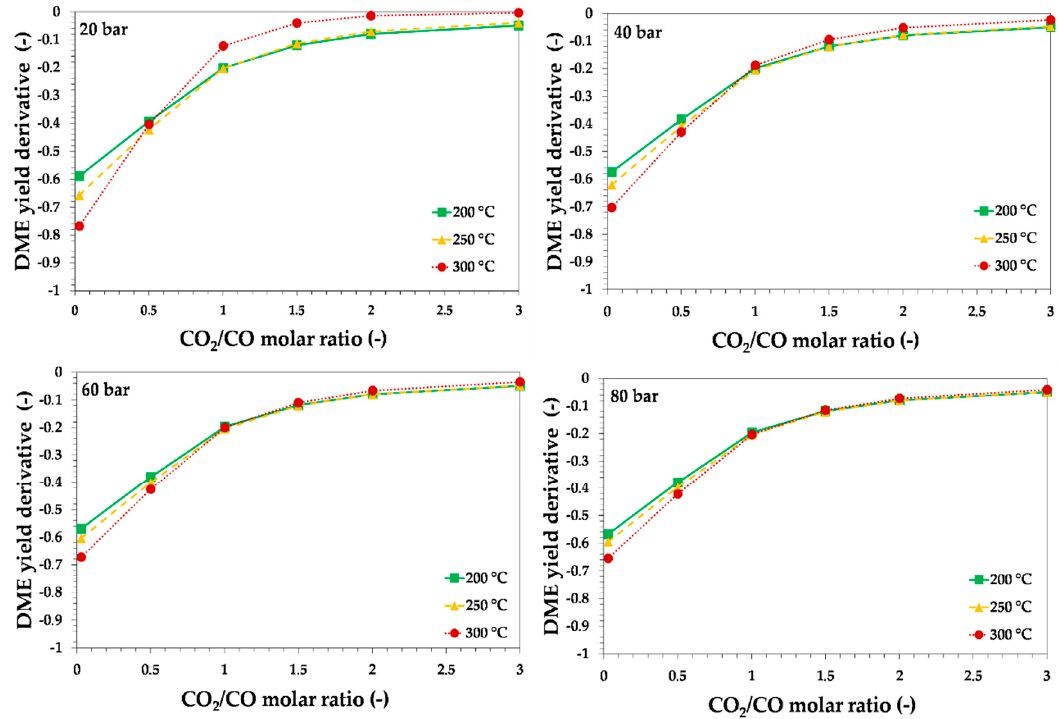
Figure 7. Theoretical equilibrium DME yield derivative with respect to CO 2 /CO molar ratio as a function of the initial CO 2 /CO molar ratio, reaction temperature and pressure, for syngas with H 2 /CO = 0.87. Lines are only a guide for the reader.